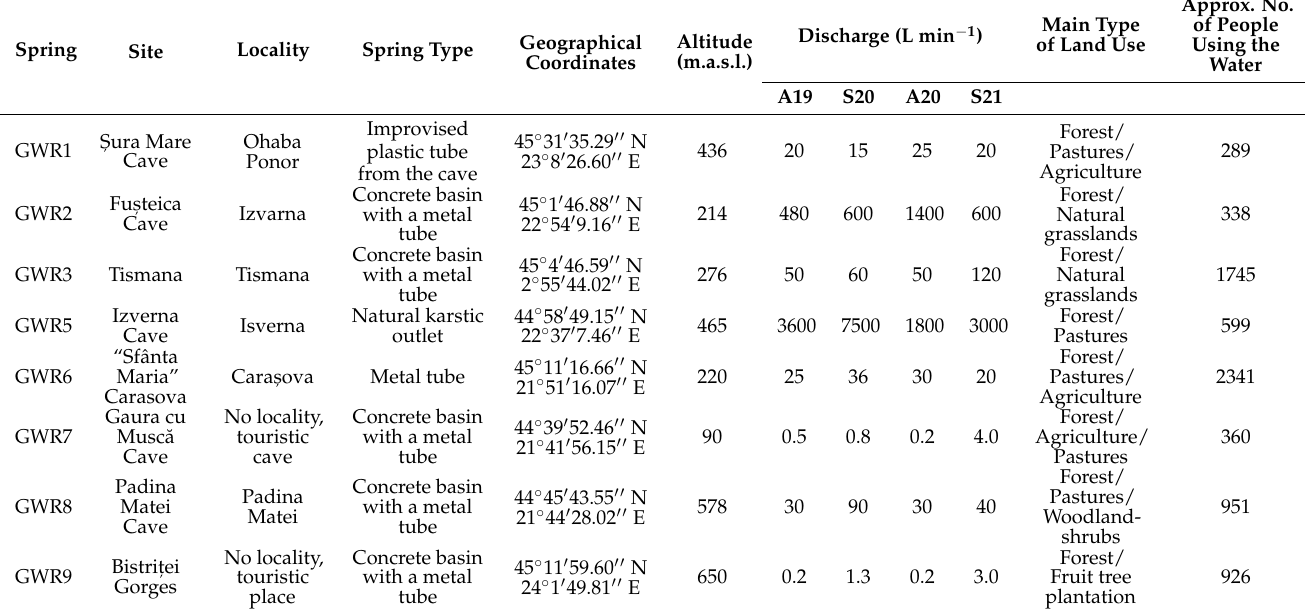
Table 1. Characteristics of the studied